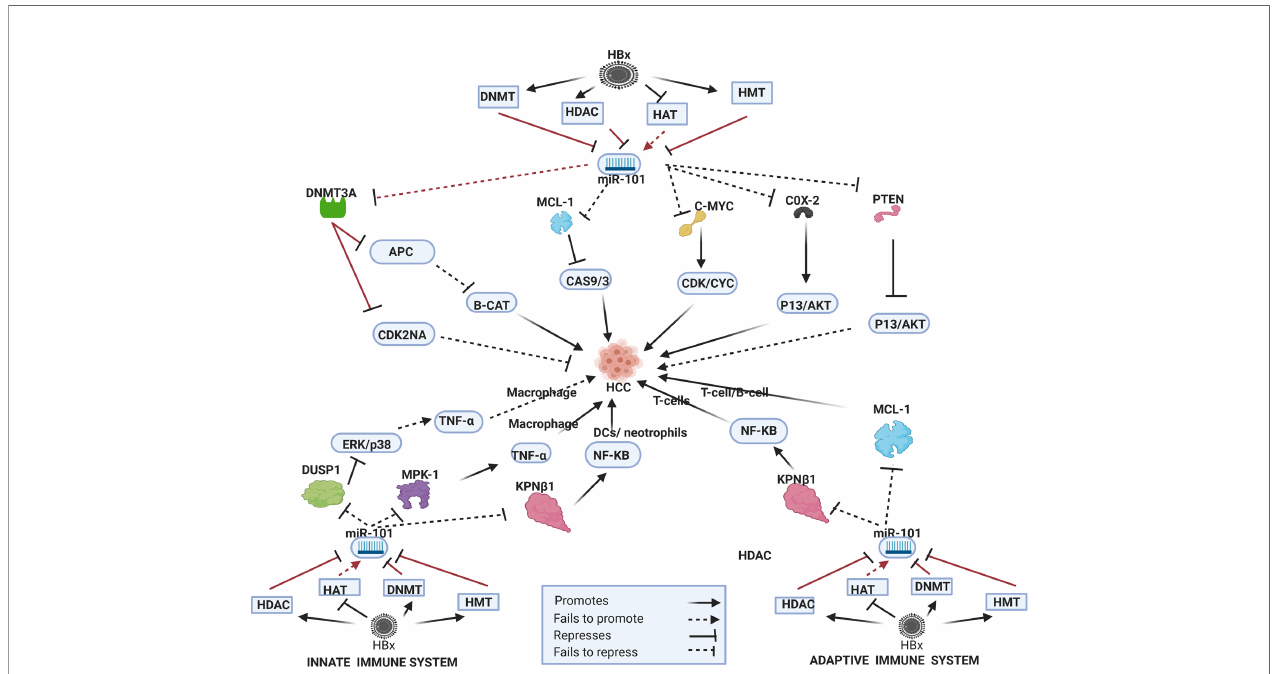
FIGURE 2 | Epi-miR-101 in HBV-HCC and immune pathways. HDAC-Histone deacetylation, HAT-histone acetylation, HMT-Histone methylation, DNMT-DNA methylation (pathways in dark red involve identi fi ed direct upstream or downstream epigenetic proteins/enzymes). HBx protein can downregulate or initiate HDAC/ HAT/DNMT/HMT to repress miR-101 modulation in various HBV-HCC pathways including WNT-B-CATENIN, TP53, and P13K/AKT to in fl uence HCC pathogenesis. HBx epigenetically downregulated miR-101 also regulates macrophage and DC expression in the innate immune system, as well as T-cell and B-cell expression in the adaptive immune